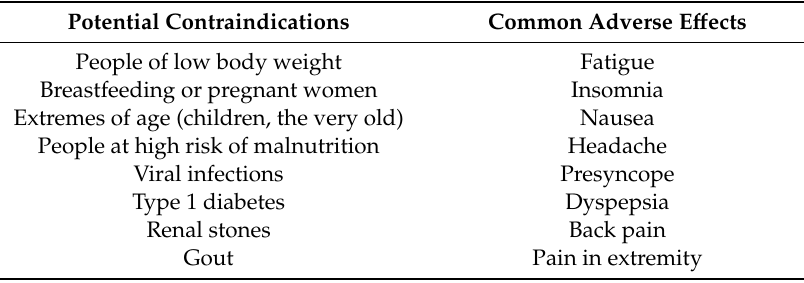
Table 3. Potential contraindications and common adverse e ff ects of